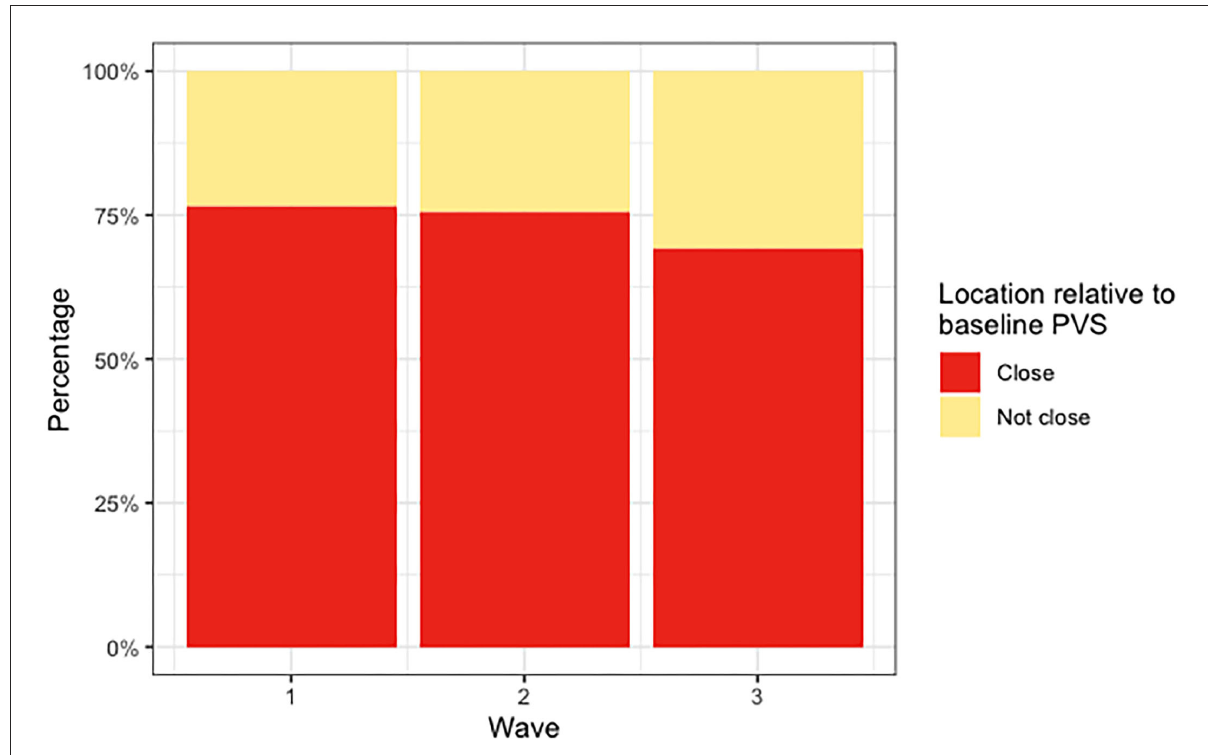
FIGURE6 Percentages of deep WMH in waves 1, 2, and 3 that were found “close” and “not close” to baseline (i.e., wave 1) PVS.